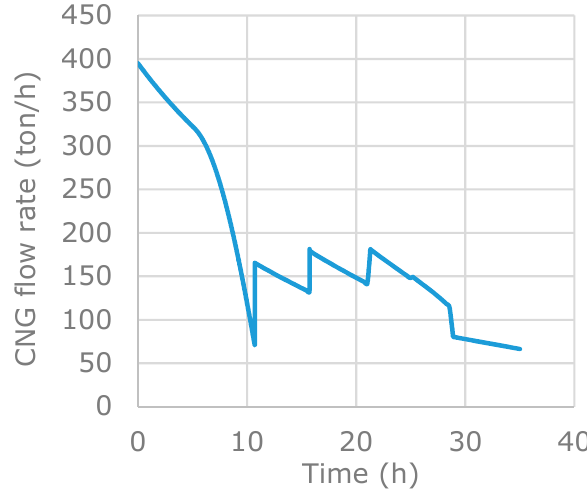
Figure 8. CNG flow rate (adiabatic loading).